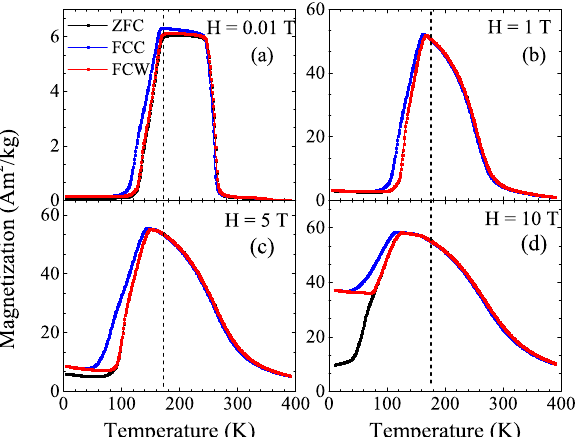
Figure 4. Magnetization as a function of temperature in 0.9 [Mn 3 GaC] + 0.1 [Ni 2 MnGa] recorded in different